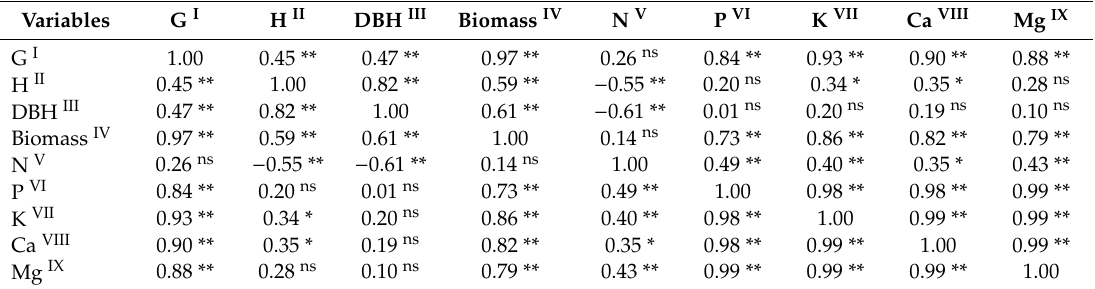
Table 2. Pearson’s correlation matrix between the predictor variables (basal area, height, and DBH) and dependent variables (biomass and